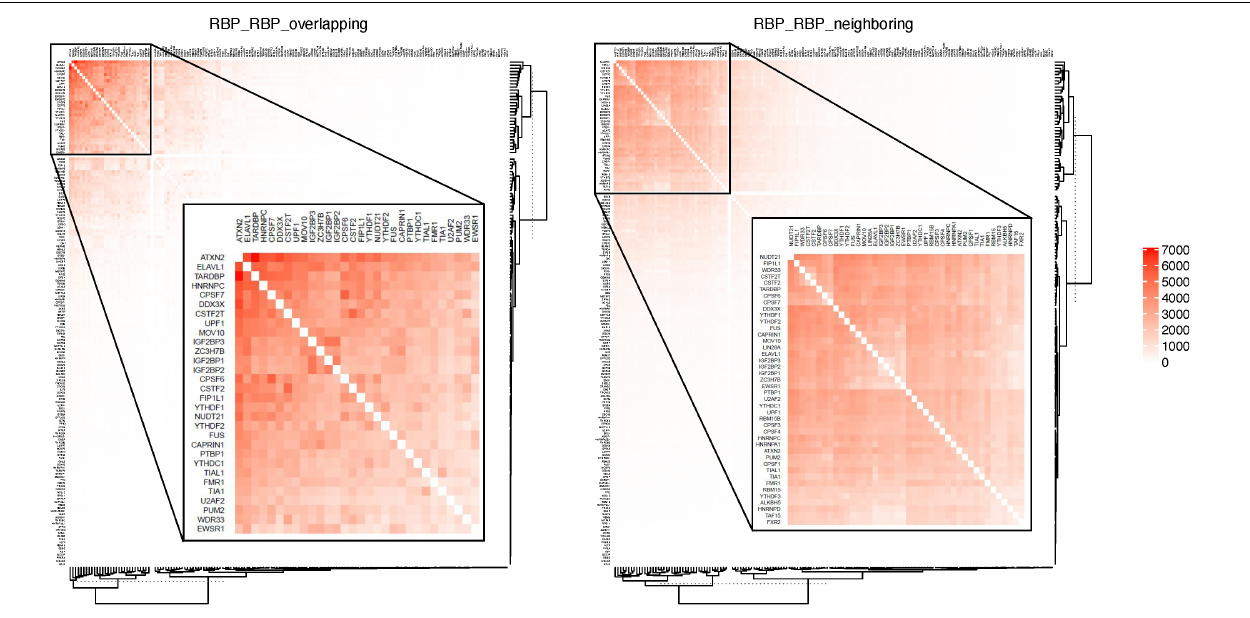
FIGURE 4 | RBPs that have overlapping or neighboring binding sites. Color in each cell indicates the number of mRNAs on which the two RBPs have overlapping or neighboring binding sites. RBPs are listed in the same order on both X - and Y -axis. The top overlapping pairs in the top left corer are magnified in the